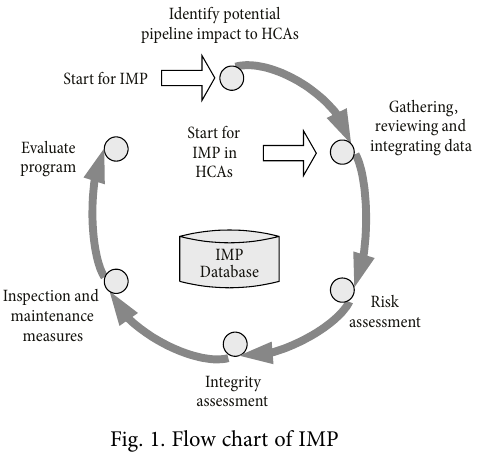
Fig. 1. Flow chart of